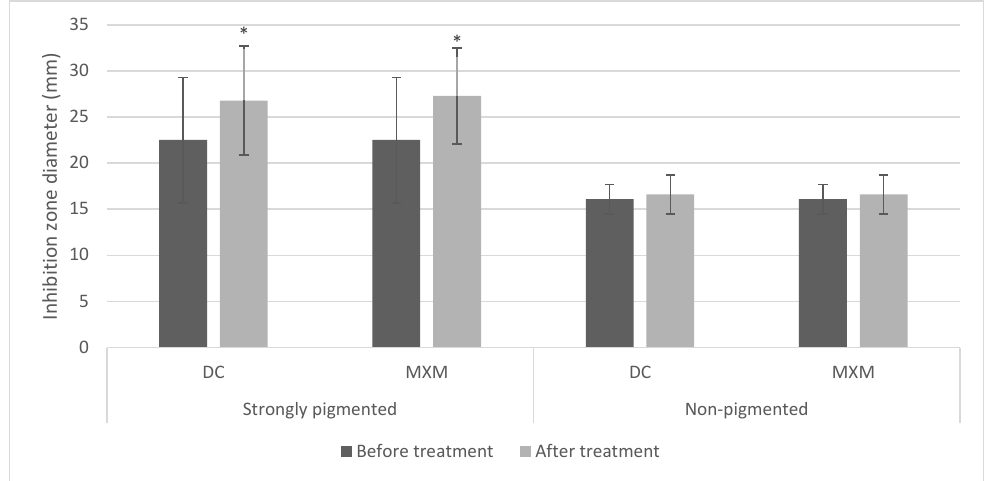
Figure 6. Bar chart representing mean and standard deviation values for inhibition zones of protease activity. Asterisks indicate statistical significance at p ≤ 0.05.